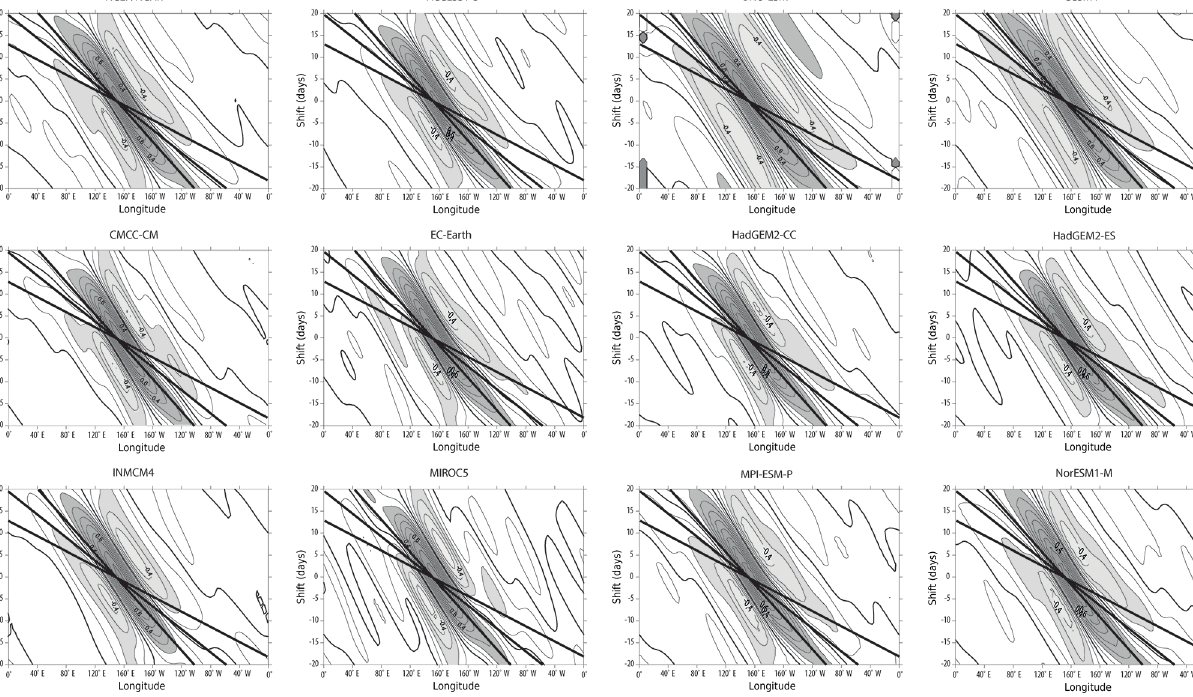
Figure 8. Lag correlation of the ER filtered U850 averaged along the Equator between 5 ◦ N and 5 ◦ S with respect to itself at the Equator and 150 ◦ E for the NCEP/NCAR Reanalysis and the CMIP5 models. The three diagonal lines correspond to phase speeds of 7, 10 and 15ms − 1